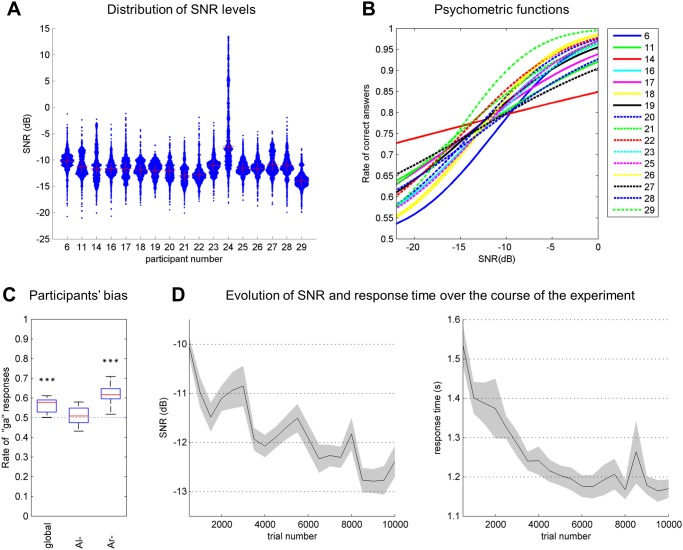
Overview of performance across all participants.A. Distribution of SNR levels for all participants (N = 17), with the mean SNR indicated with crosses. The width of each histogram is proportional to the number of trials ran at the corresponding SNR. B. Psychometric functions for participants included in the analysis (N = 16). C. Participants’ bias towards response ‘ga’ (N = 16) over the entirety of the experiment (“global”) and in conditions Al- and Ar-. Conditions with a significant bias (i.e., rate of ‘ga’ responses differing significantly from the level of 0.5 based on a random distribution, blue line) are indicated by asterisks. D. Evolution of the SNR and response time over the course of the experiment for sessions of 500 trials. Mean for the participants collectively (N = 16) with s.e.m.